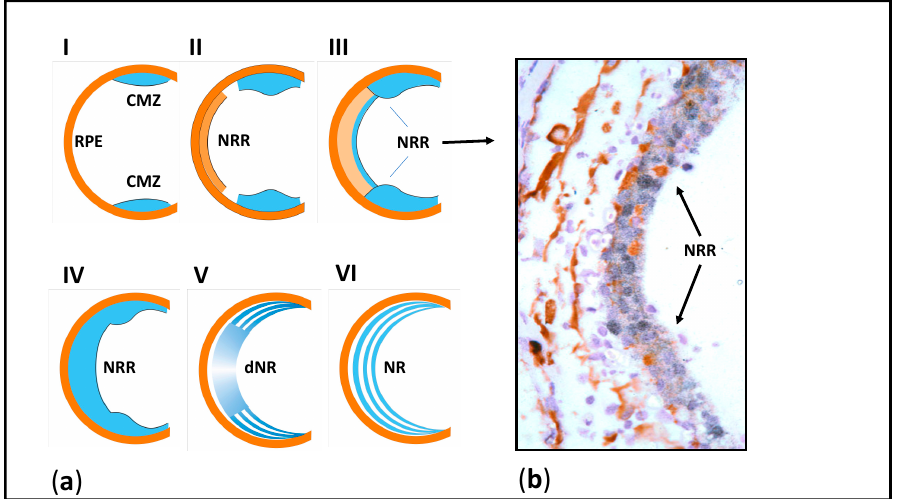
Figure 2. ( a ) Stages of retina regeneration by retinal pigment epithelium cells after surgical removal of the retina in the newt. RPE—retinal pigment epithelium, CMZ—circumferential marginal zone of the retina, NRR—neural retinal rudiment (blastema), dNR—differentiating neural retina, NR—newly formed neural retina. ( b ) Histological picture of retinal regenerate (arrows). Retinal rudiment cells have a high synthetic activity (black nuclei—intense inclusion of 3 H-labelled tryptophan).